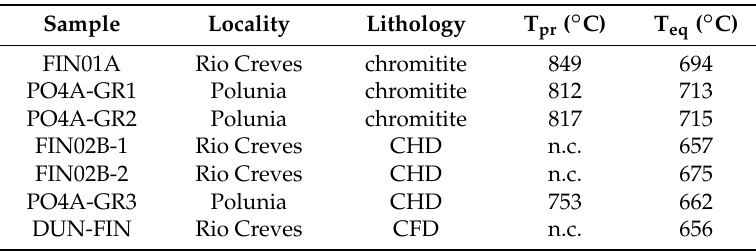
Table 4. Primary and re-equilibration temperatures (respectively T pr and T eq ) following Ballhaus et al. [4] calibration.